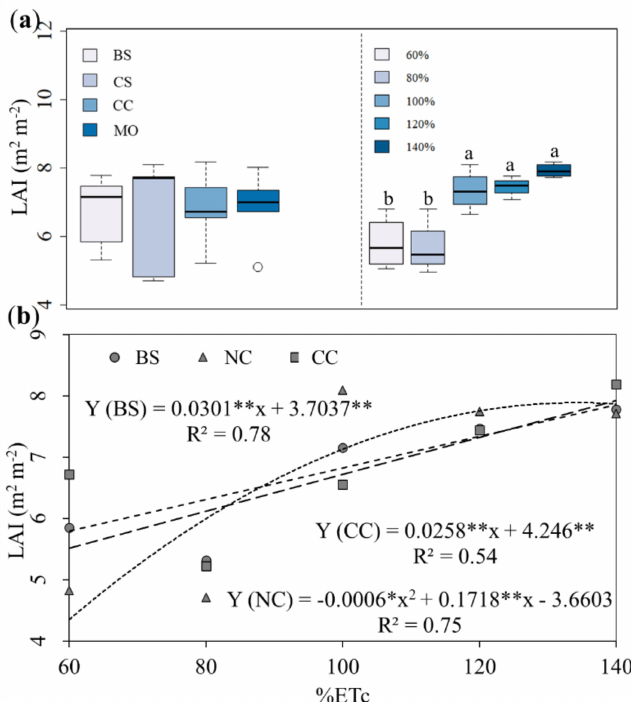
Figure 5. Box plot of the sorghum leaf area index (LAI), depending on the soil cover (C), the irrigation depths (ID) with wastewater ( a ), and the interaction (C × ID) ( b ). Averages were compared using Tukey’s test ( p < 0.05) and are indicated by lowercase letters. The significant regression coefficients are for p < 0.01 (**) and p < 0.05